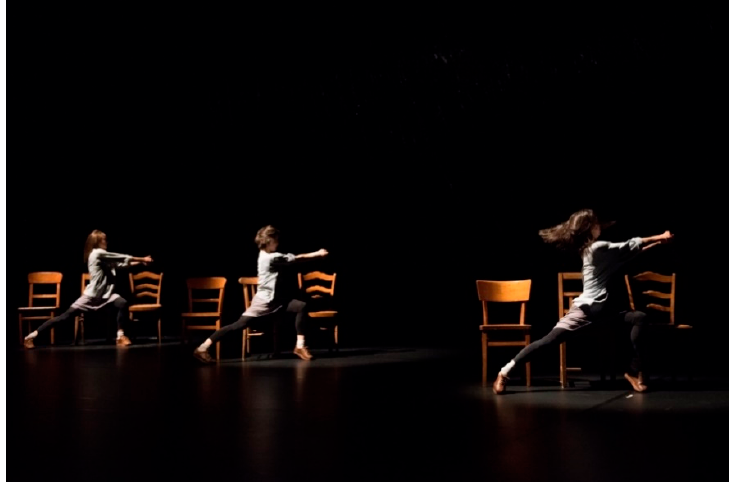
Figure 5. Rosas danst Rosas (2017) Anne Teresa De Keersmaeker / Rosas © Anne van Aerschot. Used with permission.